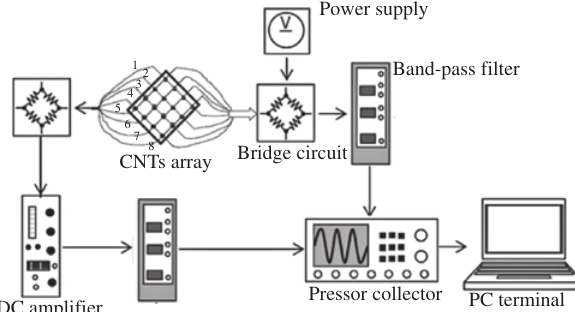
Figure 5: The stress measurement system of 3-D braided compos- ites using